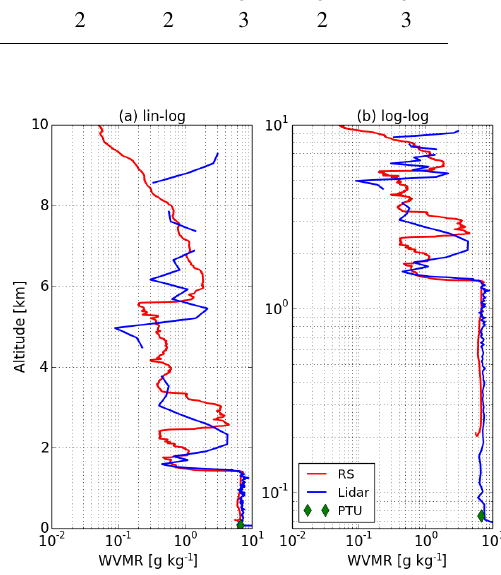
Figure 9. Vertical water vapor mixing ratio profiles measured by the Rameau lidar (blue) on 3 June 2015 at 20:42 at Saint-Mandé and a radiosonde (red) on 3 June 2015 at 23:30 at Trappes (30km from Saint-Mandé): (a) altitude in linear scale, and (b) altitude in log scale. The PTU measurement at 15m above ground level is also shown (green diamond). The lidar profile was calibrated with the PTU data from 12 March